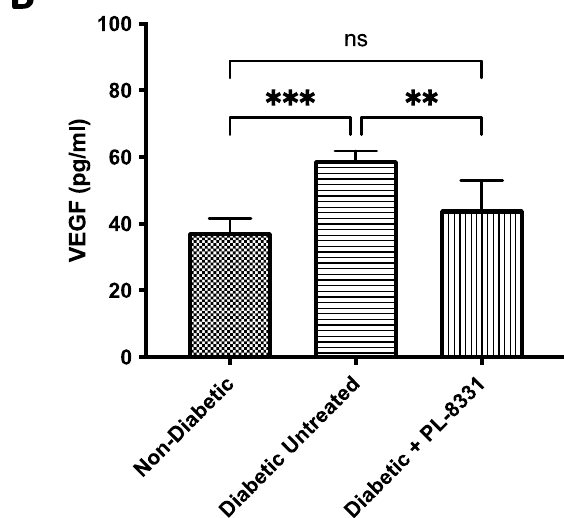
Figure 5. The effects of PL-8331-treatment of diabetes on RPE regulation of LPS-stimulated macro- phages. The RPE eyecup conditioned media (CM) were collected from 24 h cultures of RPE eyecups of non-diabetic, diabetic, and PL-8331-treated diabetic mice. The macrophages were treated with the CM, stimulated with LPS, and 24 hrs later, the culture media was assayed for ( A ) TNF α and ( B ) IL-10 by ELISA. ( A ) The production of TNF- α from LPS-stimulated macrophages treated with RPE